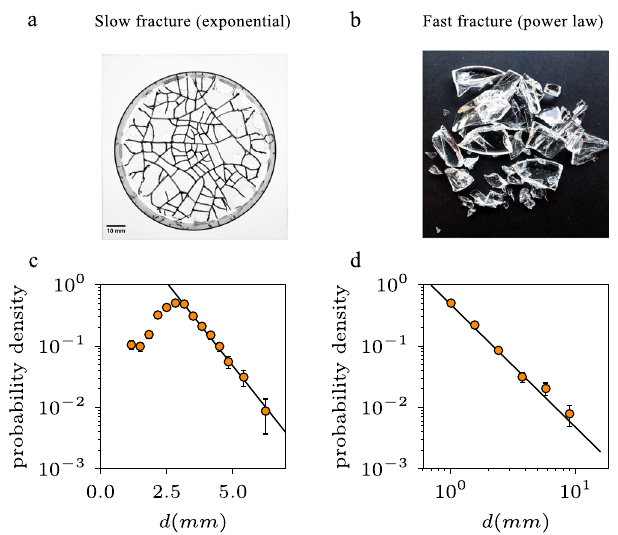
Fig. 4 Slow versus fast fracture. Fragmentation of sugar glass disks in a slow controlled way (left) compared with a fast catastrophic fragmentation (right). a A sugar glass disk, slowly fragmented using a mismatch in thermal expansion between the bottom plate and the sugar glass. The fracture lines are marked to make them clearly visible. b Fragments of a sugar glass disk fragmented by the impact on a solid surface. c The fragment size distribution of the slowly fractured sugar glass disks as the one shown in a , with error bars indicating the SD. The distribution is exponential with a characteristic length scale d 1 = 0.8 mm (as indicated by the solid line) and a cutoff at ~3mm, con fi rming that this breakup is consistent with a random process. d Fragment size distribution of the dropped disks as one shown in b . This breakup, which represents the typical fragmentation study, is indeed power-law, with an exponent of 2. This shows that you can fragment the same material in different ways to have either random breakup (left) or hierarchical breakup (right). Source data are provided as a Source Data fi